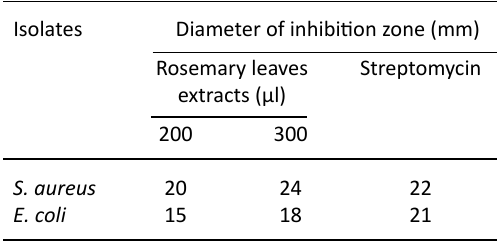
Table 1. Antibacterial activities of rosemary leaves extracts against E. coli and S. aureus